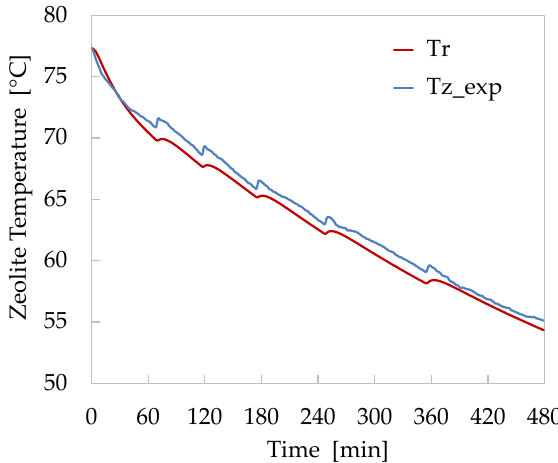
Figure 9. Comparison of numerical (red) and experimental (blue) temperature trends of zeolite bed for the adsorption Test 5.